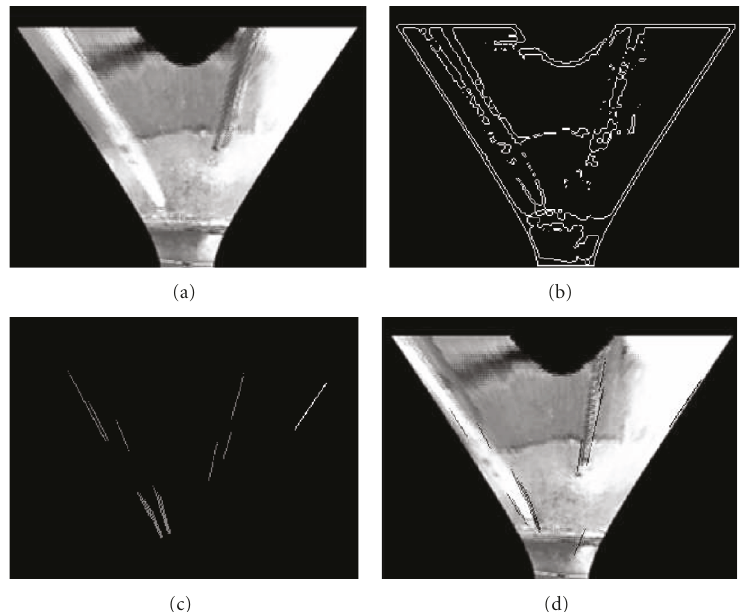
Figure 12: The results in the feature searching procedure by using profile images, (a) the sharpened remapped image, (b) the profile image, (c) the scanned feature segments, and (d) the scanned feature segments superposed on the sharpened remapped image.